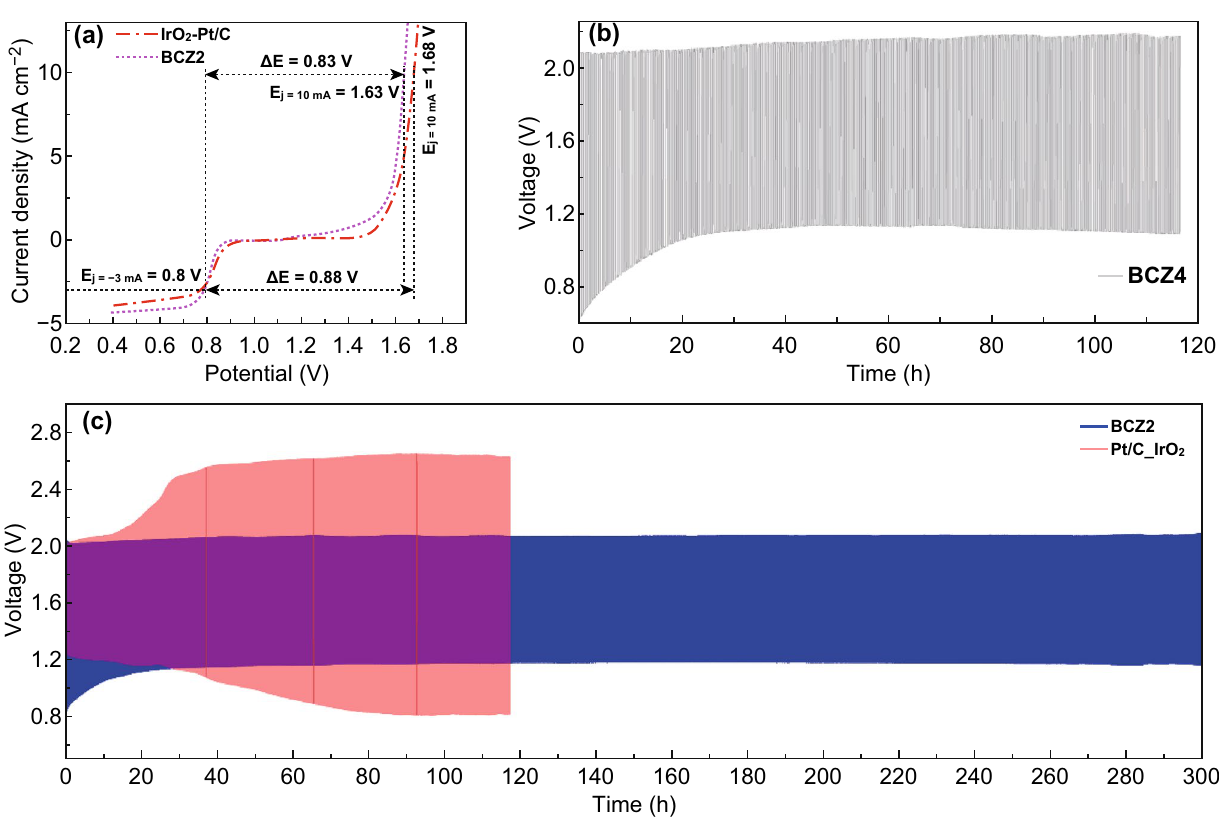
Fig. 4 a Overall polarization curves of BCZ2 and commercial Pt/C and IrO 2 in 0.1 M KOH. Rechargeable zinc–air battery tests. b galvanostatic charge/discharge test based on BCZ4and c BCZ2 and Pt/C and IrO 2 mixture catalysts tested for Cyclic stability at 5 mA cm −2 for 300 h